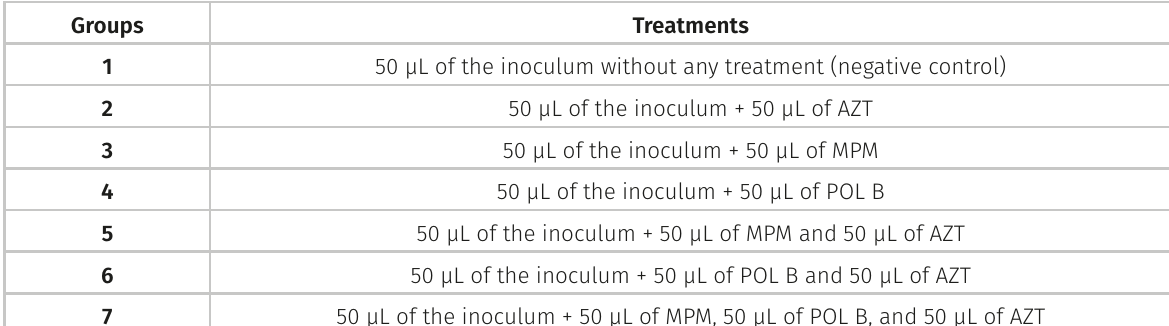
Table II. Experimental groups used for proteomic analyses. The antibiotics were dissolved at 1 mg·mL -1 .